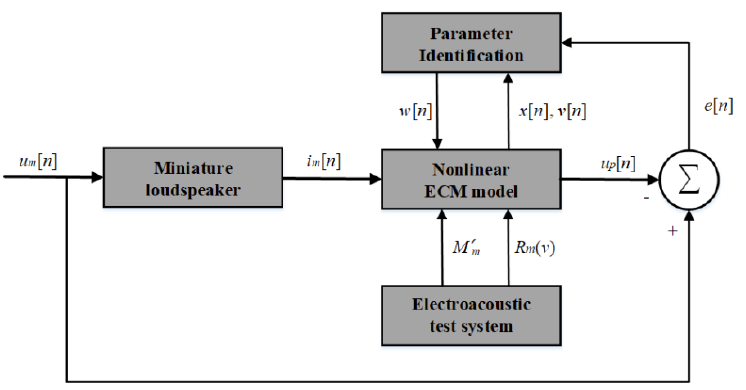
Figure 5. Block diagram of the identification process.